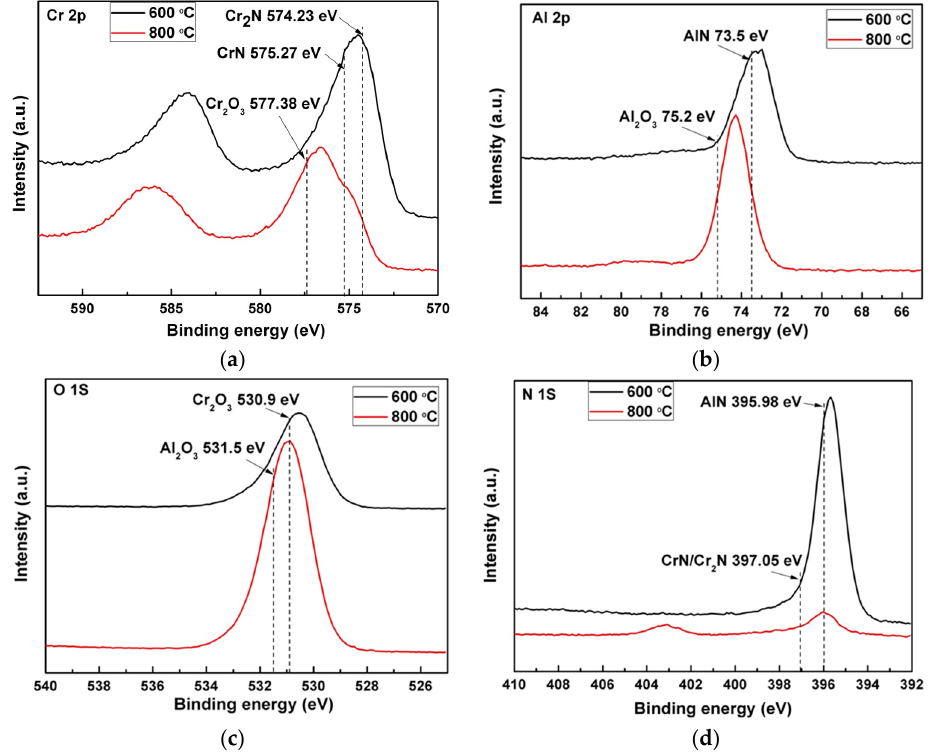
Figure 14. Detailed core level XPS spectra on the worn surface of the AlCrN coatings deposited at 450 V charge voltage after the pin ‐ on ‐ disk wear tests at 600 °C and 800 °C: ( a ) Cr 2p; ( b ) Al 2p; ( c ) O 1s; ( d ) N 1s.